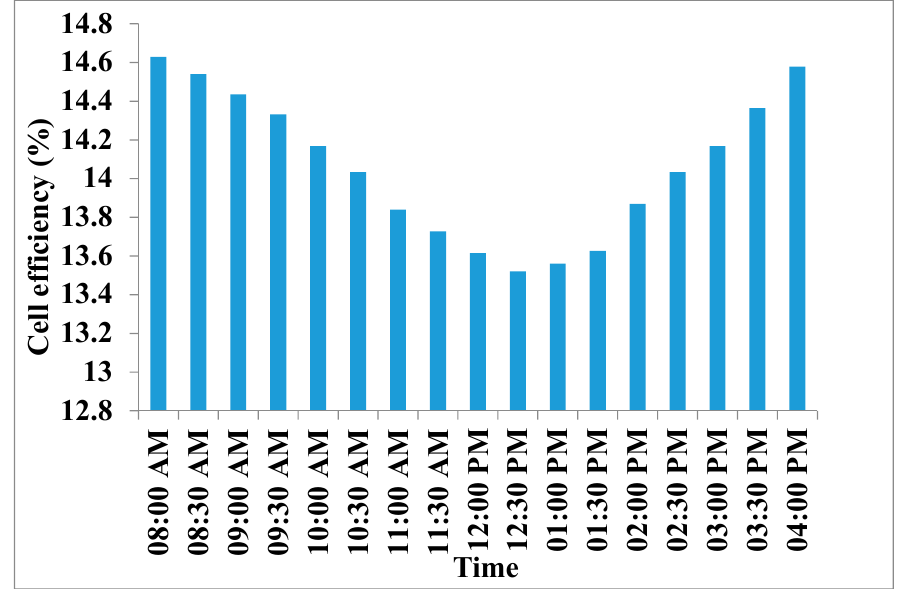
Figure 5. Variation of PV cell conversion efficiency of PVT system with time during the day, 15 May